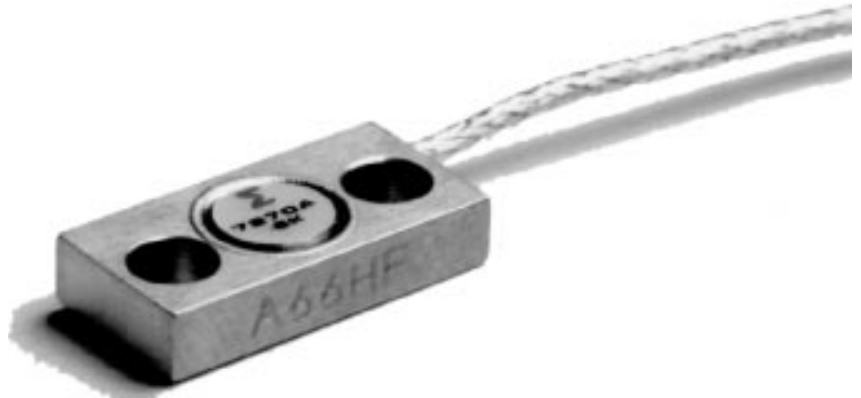
Fig. 5a. The first high-g (200,000 g) sculptured silicon accelerometer (Endevco, 1983).